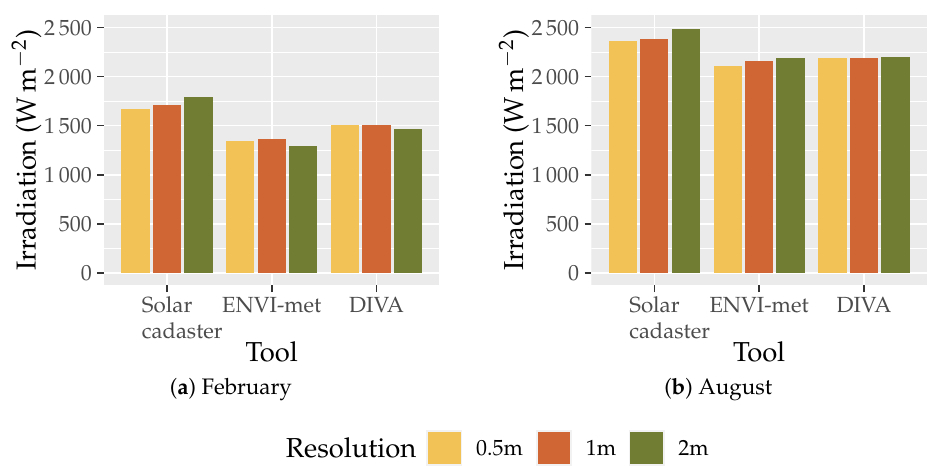
Figure 6. Cumulative irradiation for different mesh resolutions.